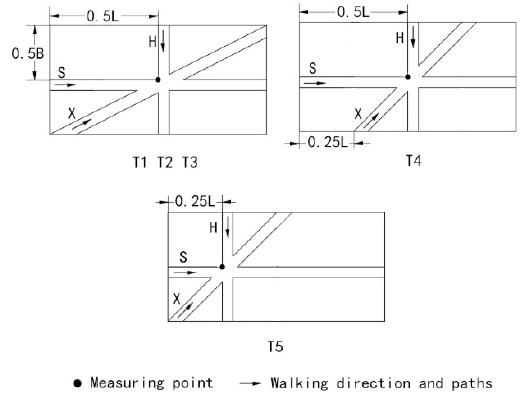
Figure 12. Layout plan of pedestrian load test.